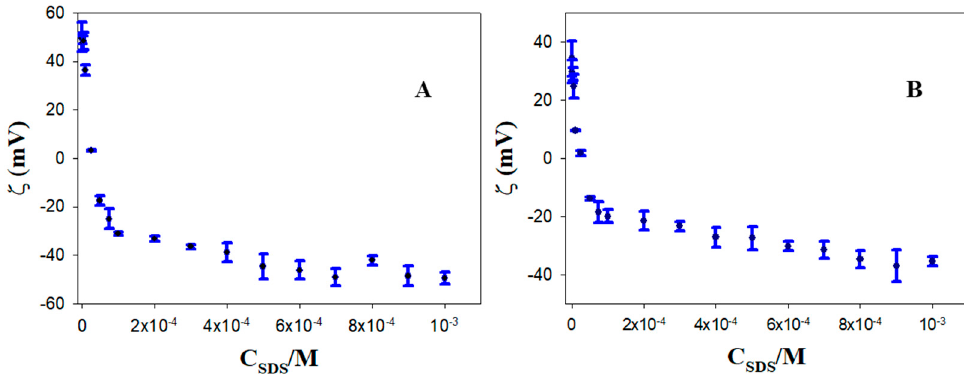
Figure 4. Zeta potential of the gold nanoparticles as a function of the SDS concentrations. ( A ) Au@16- 3-16/SDS system. ( B ) Au@16-6-16/SDS